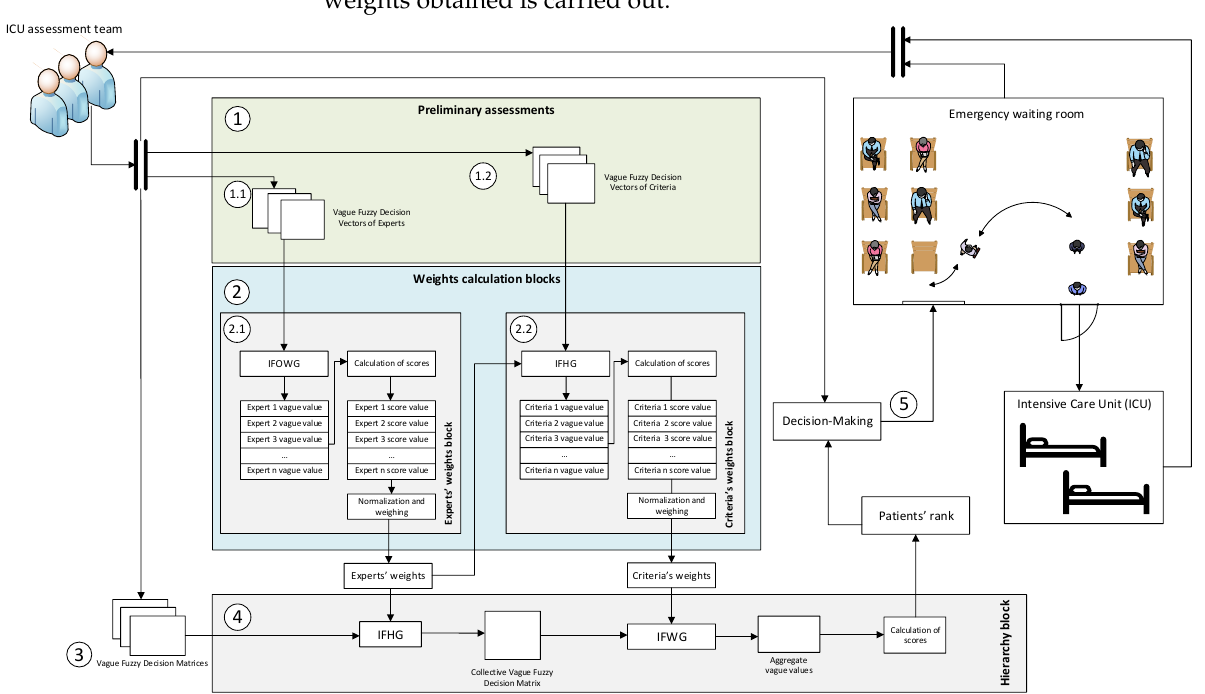
Figure 1. Flow diagram for the decision support system. This diagram shows the different flows of information across the system stages presented in Table 5. Label 1 is related with the preliminary assessments, label 2 with the weightings calculation block, label 3 with the patients’ status assessment, label 4 with the hierarchy calculation block, and finally, label 5 is related with decision-making.